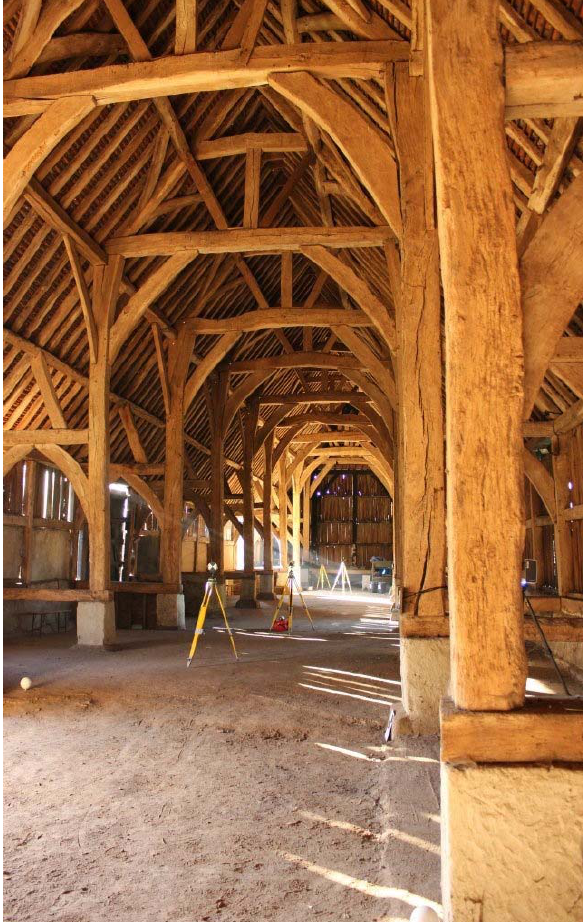
Fig. 1 The interior of the Harmondsworth Barn while the survey was in progress. Photo Bev